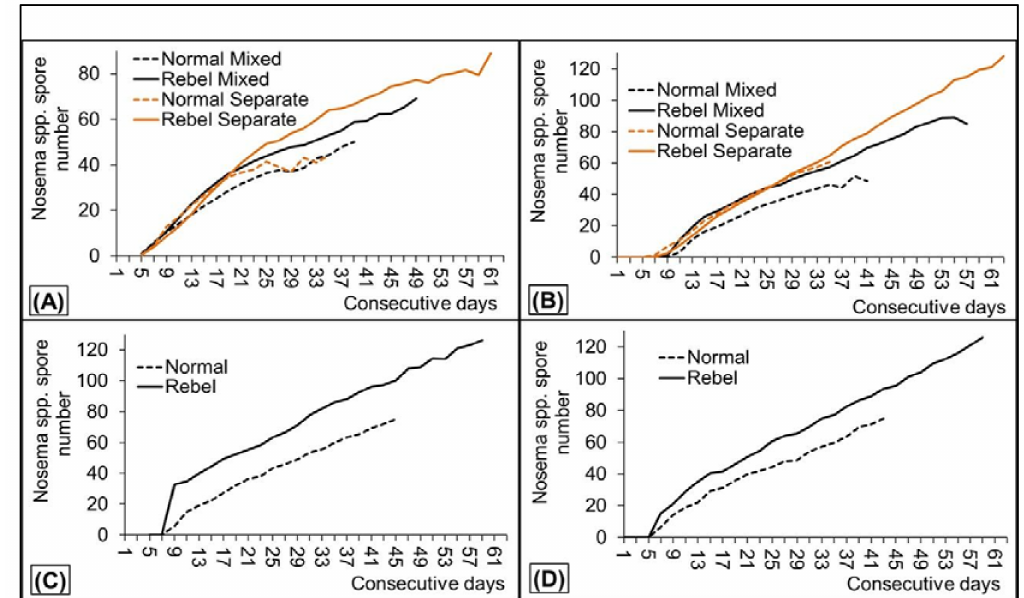
Figure 3. Nosema spp. spore number in 1 µ L in the macerates of abdomens of rebel versus normal workers kept in cages ( A , B —repetition 1 and 2) or kept in the hives ( C , D —repetition 1 and 2). Explanations: Rebel—rebel workers; Normal—normal workers. All necessary statistics are included in Supplementary Materials (Table